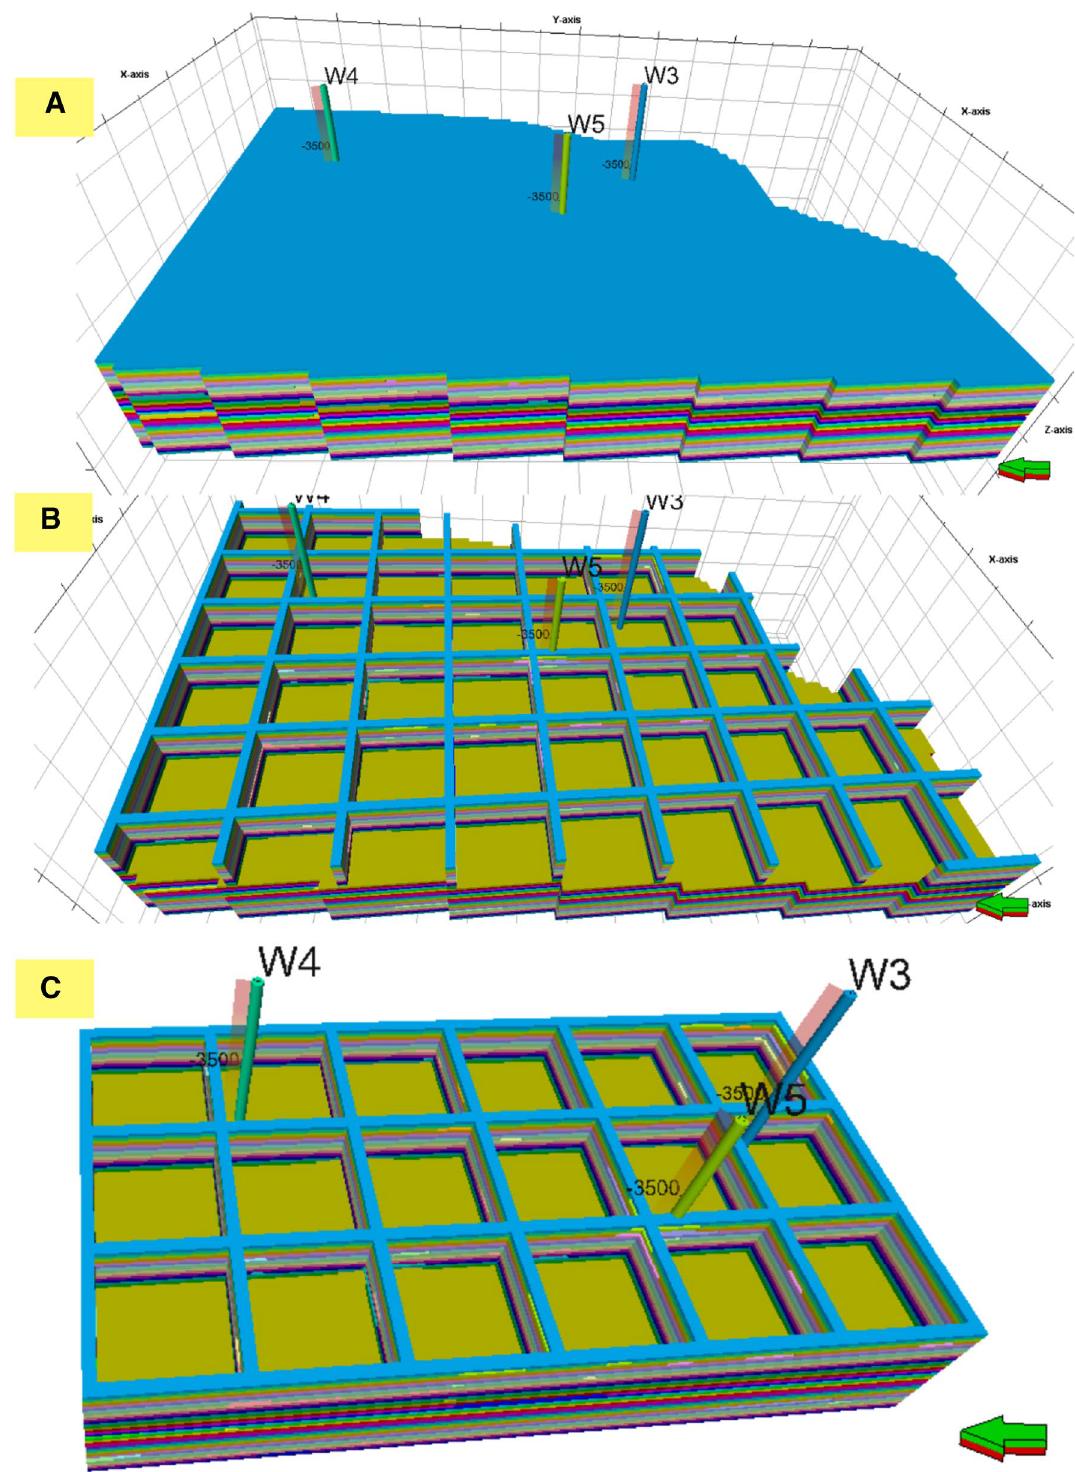
Fig. 7 3D geological model through toggle simbox view, showing the structural model including the fence model without taking fault into consideration. a 3D regional geological model of the study area; b three-dimensional structural fence model of a at X -axis (1, 1, 10),